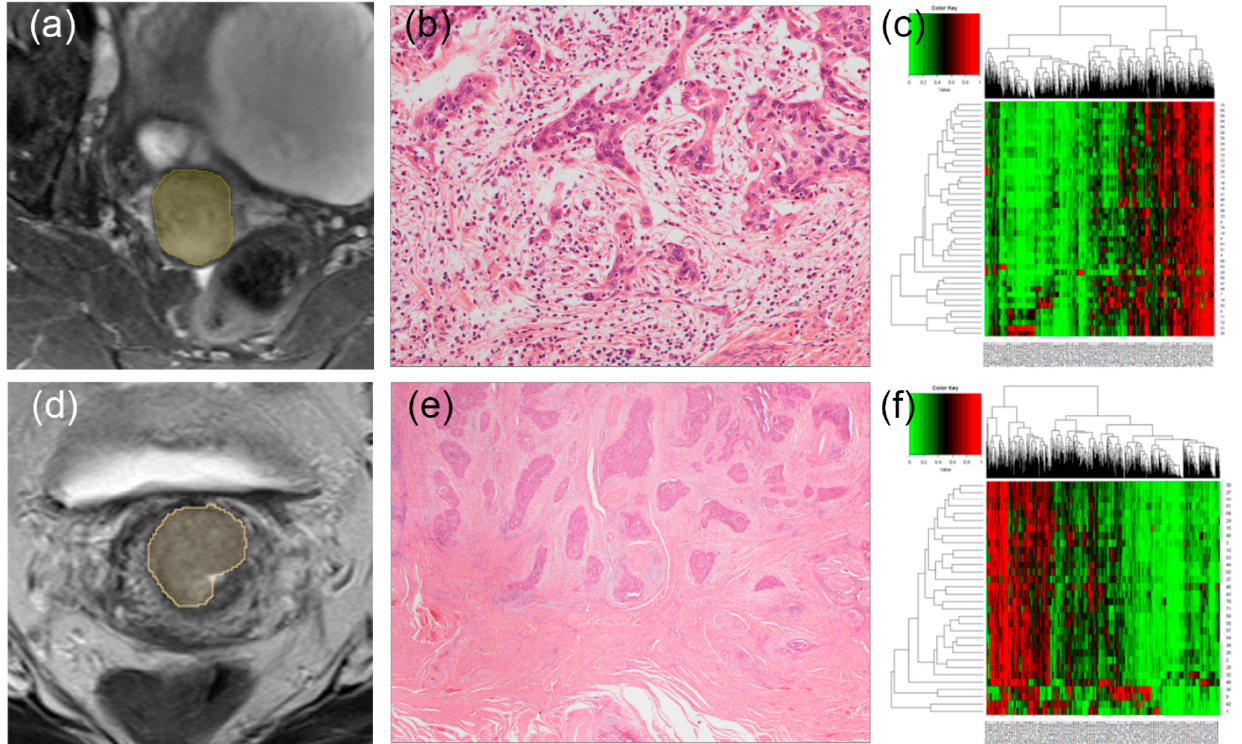
Figure 3. MRI images of two representative cases showing a high tumor budding (TB) count ( a ) and low TB count ( c ). Corresponding hematoxylin- and eosin-stained images at 100× original magnification taken from a radical hysterectomy specimen ( b , d ), respectively. ( b ) A patient shows a high TB count. ( d ) A patient shows a low TB count. Corresponding heatmaps showing the radiomic features of those who had a high TB count ( e ) and low TB count ( f ). Each row and column represent one patient and one radiomic feature, respectively.